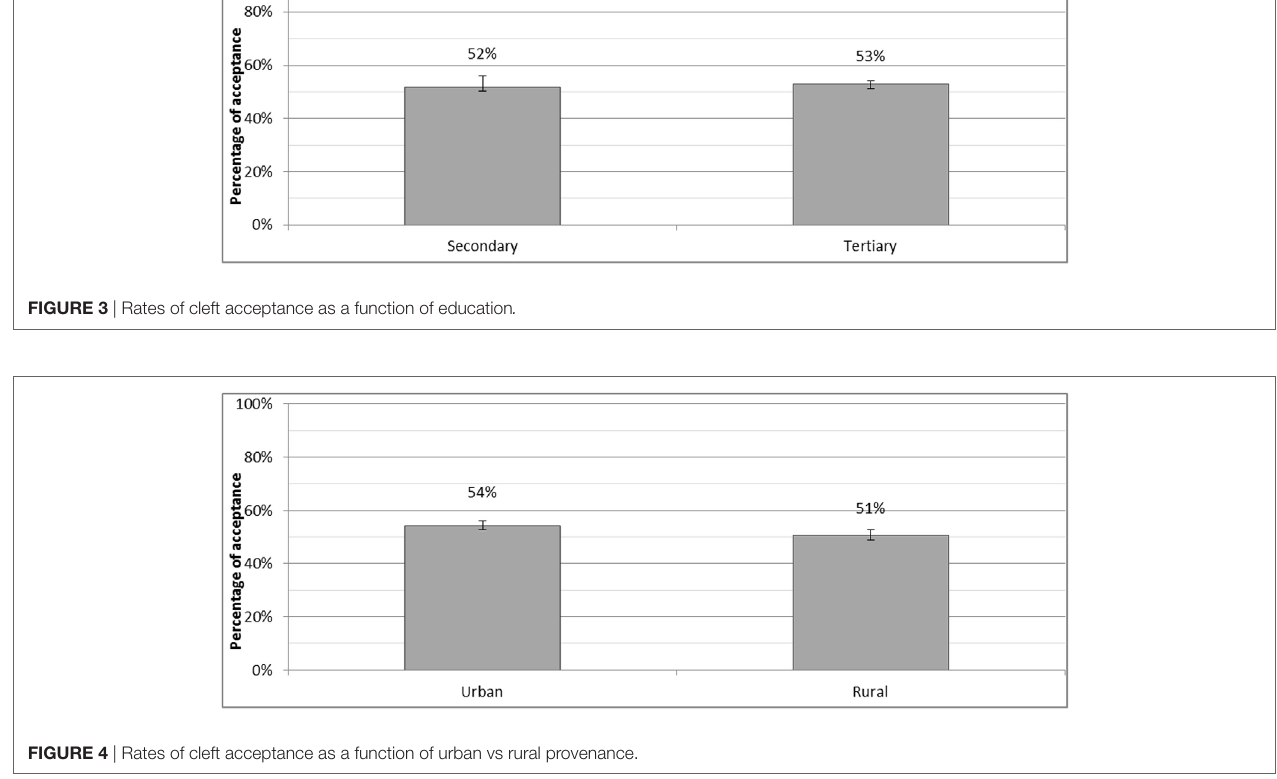
FigUre 4 | Rates of cleft acceptance as a function of urban vs rural provenance.